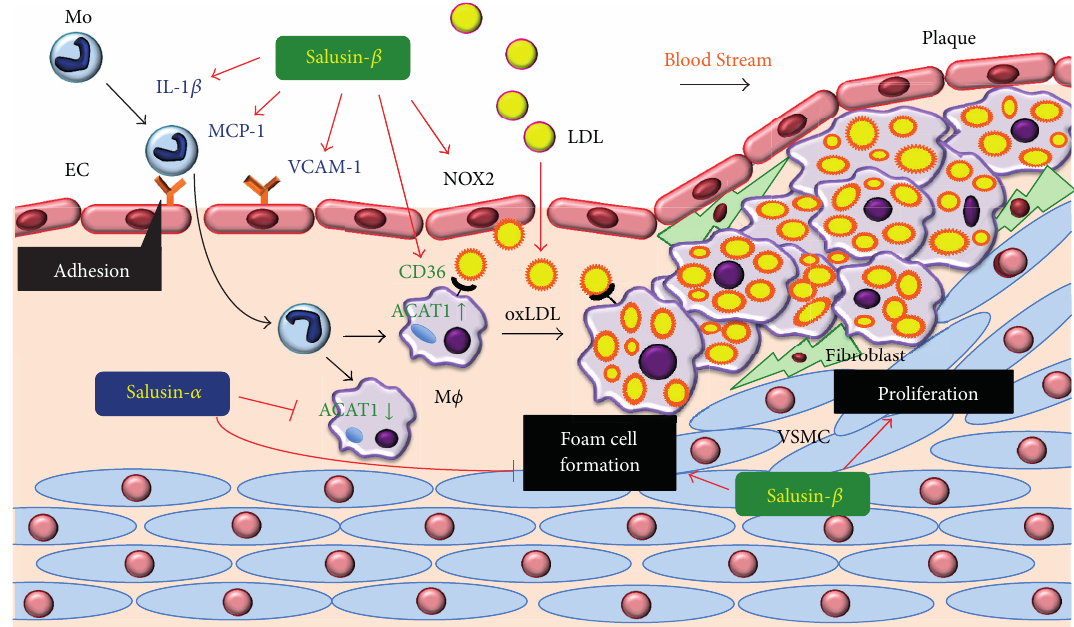
Figure 2: Modulatory effects of salusin- 𝛼 and salusin- 𝛽 on atherogenesis in vascular cells. Mo = monocyte, M 𝜙 =